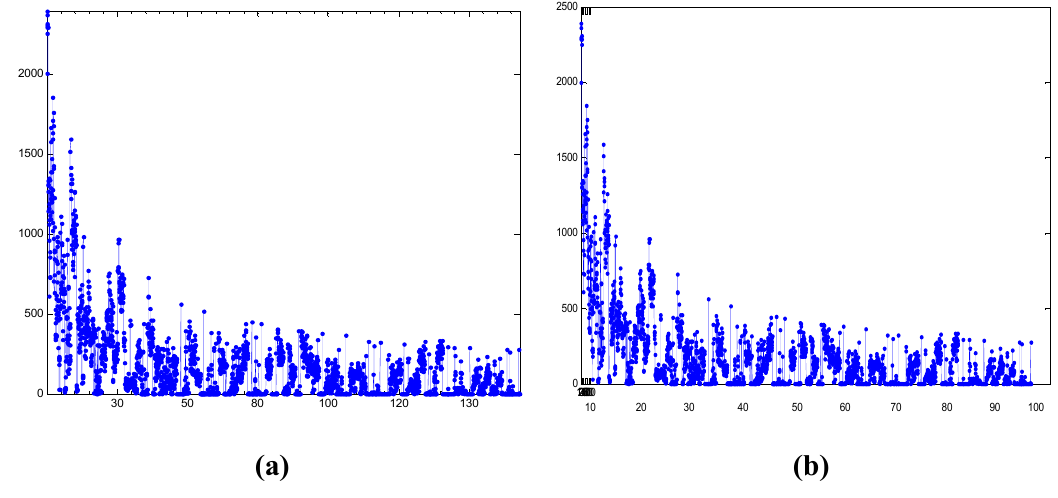
Figure 1. ( a ) The distribution of function word frequency matrix D FW ; ( b ) distribution of word bi-grams frequency matrix D bigram